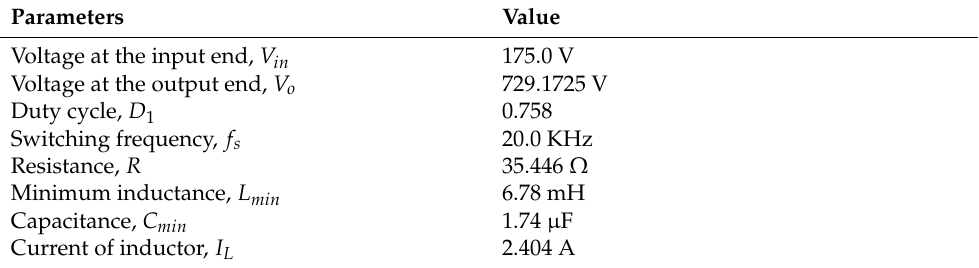
Table 4. Specifications of the second stage.